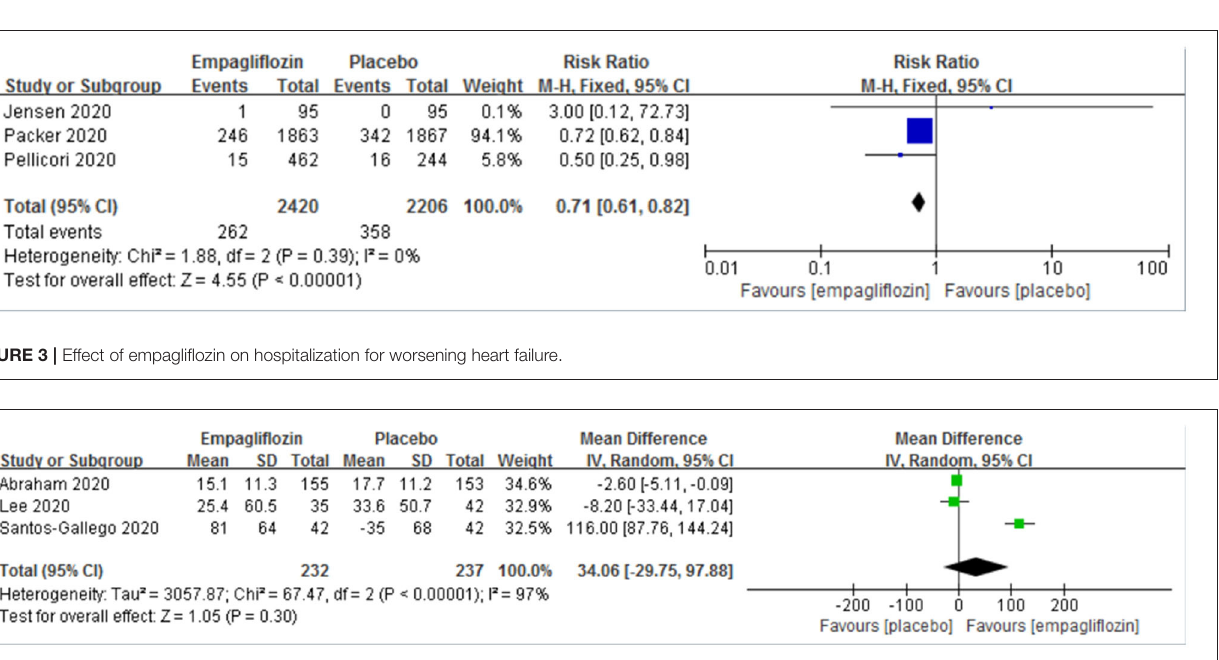
FIGURE 4 | Effect of empagliflozin on the change in the 6-min walk test from